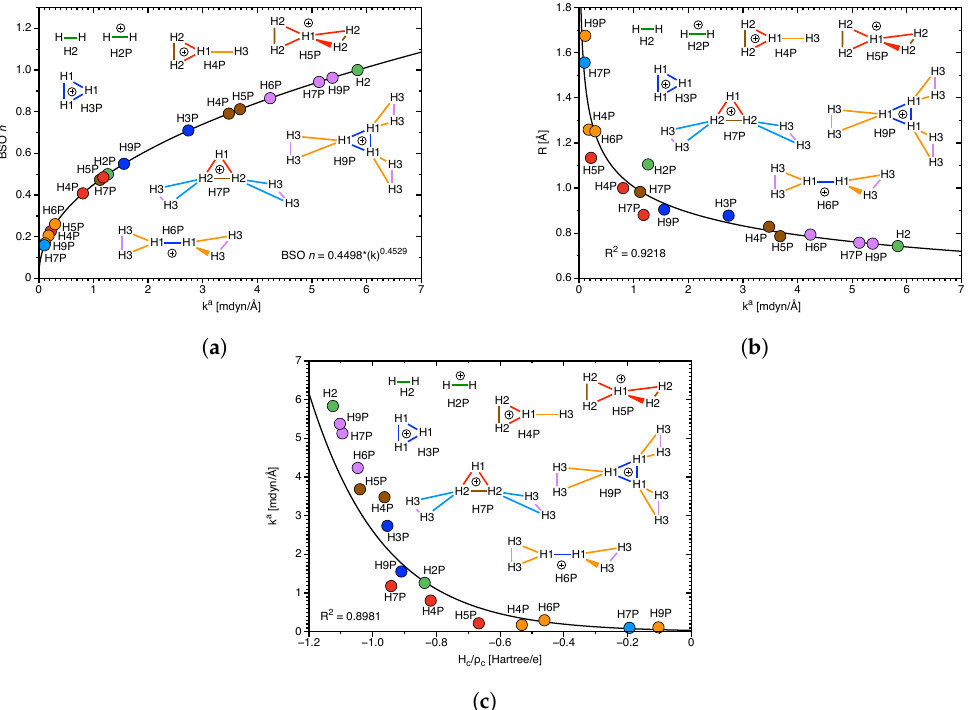
Figure 9. ( a ) BSO n(HH) as a function of the local mode force constant k a (HH); power relationship based on H 2 and H + references see text. ( b ) Correlation of distance R(HH) and k a (HH). ( c ) Correlation 2 of k a (HH) and normalized energy density H c / ρ c